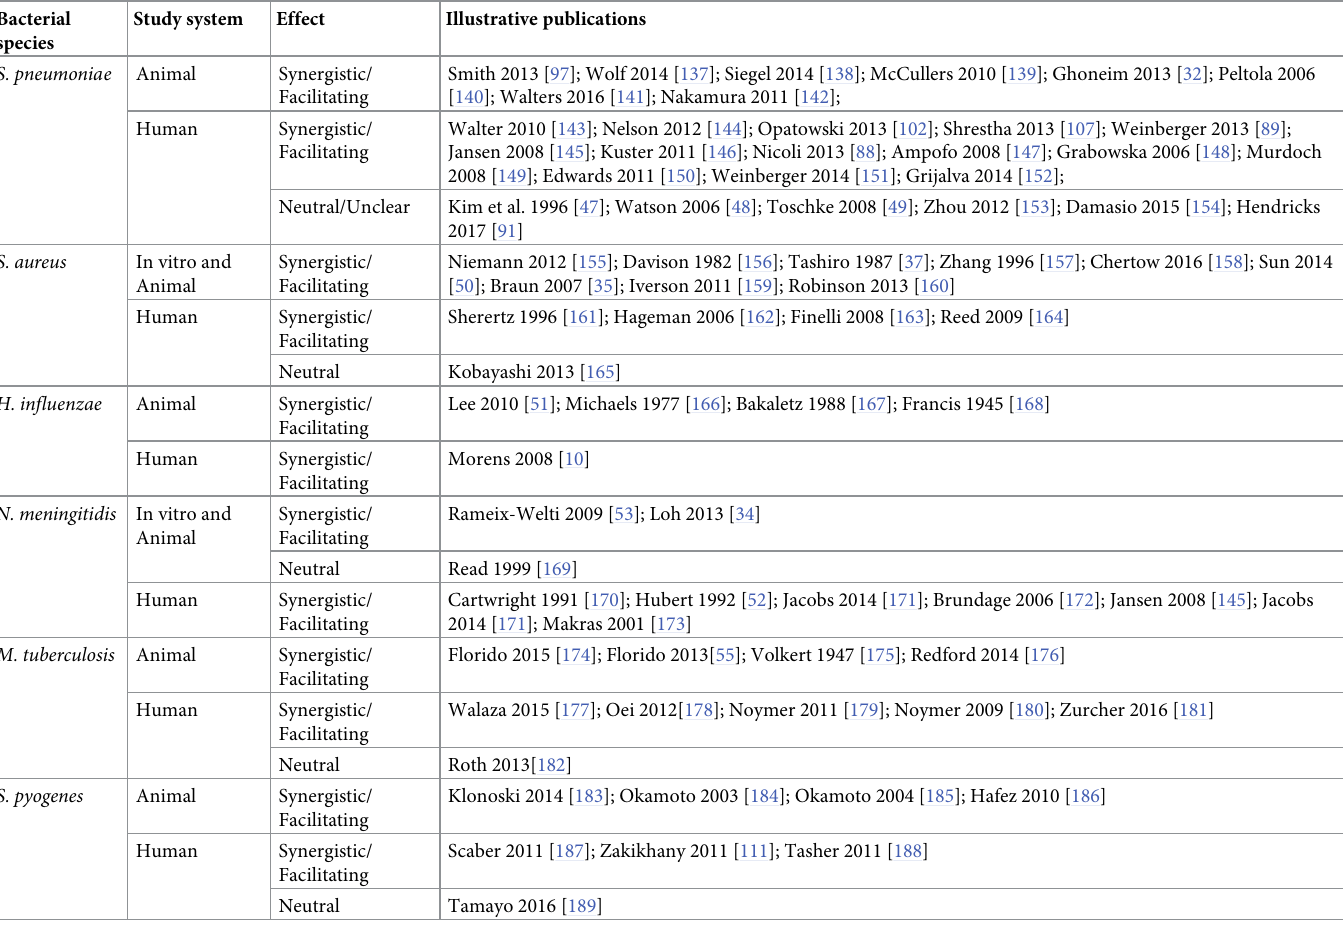
Table 1. Bacteria whose colonization or infection course may be affected by interaction with influenza. Bacterial